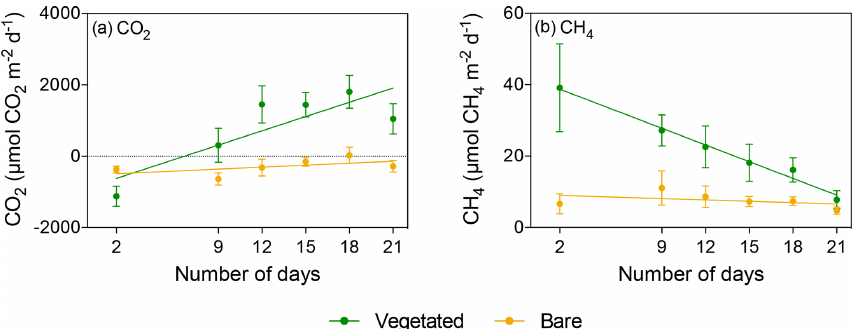
Figure 4. Mean ± SE (a) CO 2 and (b) CH 4 fluxes in vegetated (green) and bare (yellow) sediments of communities exposed to prolonged darkness over the experimental period (number of days since the onset of the experiment).